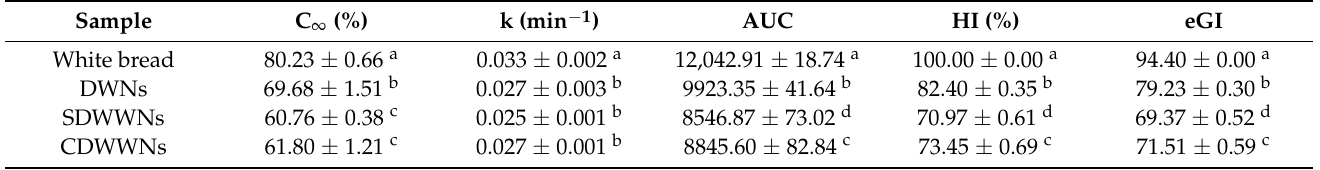
Table 4. Digest model parameters and estimated glycemic index of the dried